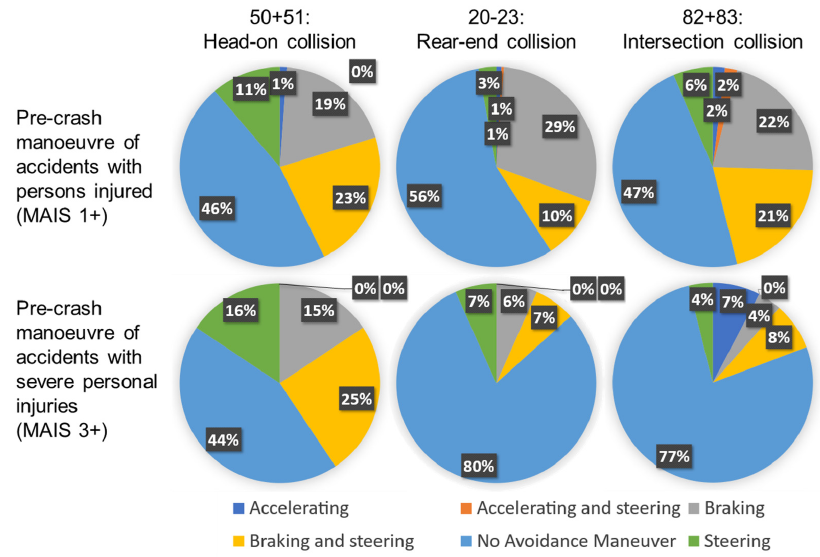
Figure 3. Manoeuvres of the drivers in the pre-crash within the selected scenarios divided into accidents with casualties, minor injuries and serious injuries. The other investigation parameters are determined individually for each scenario.